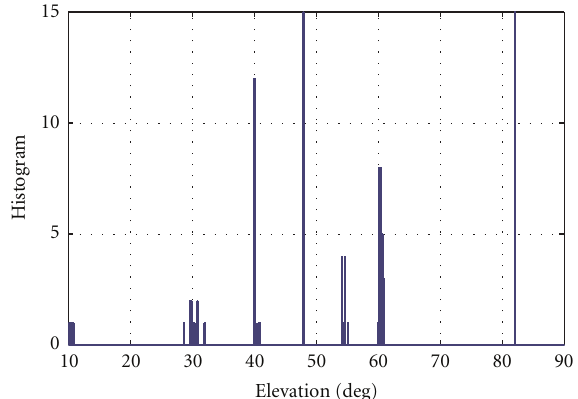
Figure 12: The cross-correlation among the eigenvectors of signal subspace when mutual coupling is uncompensated.